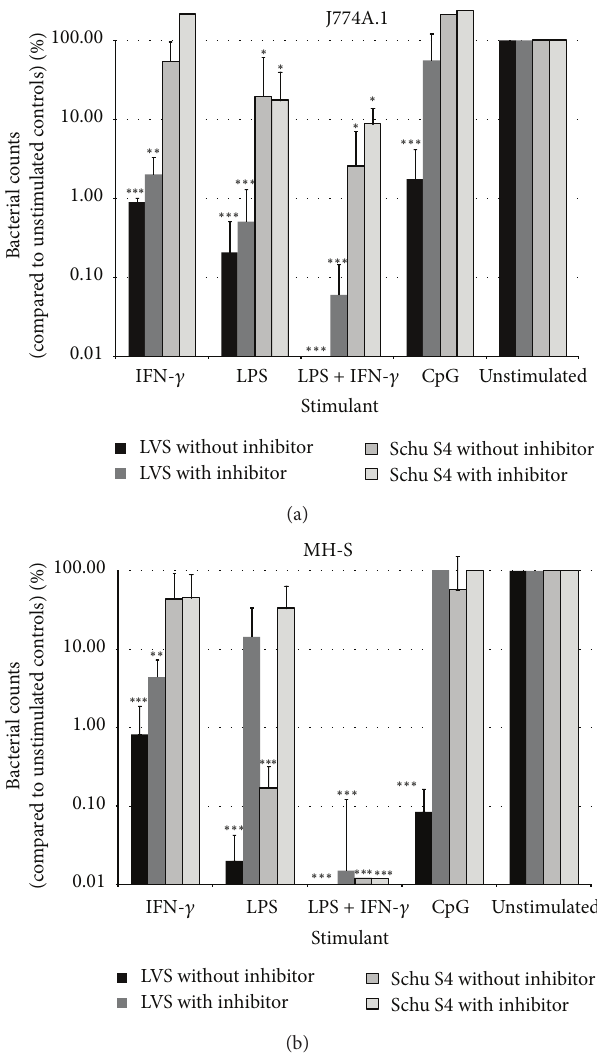
Figure 3: ((a) and (b)) Intracellular counts 24 hours after stimula- tion and infection of J774A.1 cells (a) and MH-S cells (b). Stimulant concentrations added were IFN- 𝛾 (1 𝜇 g/mL), LPS (5 𝜇 g/mL), IFN- 𝛾 + LPS (1 𝜇 g/mL + 5 𝜇 g/mL), and CpG (10 𝜇 g/mL). Nitric oxide pro- duction was inhibited by 4 mM N G -monomethyl-L-arginine added before stimulation. Values are the means and SEM from at least three independent experiments, with the starting infection given a value of 1% and the maximal growth achieved (in unstimulated cells) as 100%. Significant differences in intracellular counts between stimulatedandunstimulatedcellsareshown(significance ∗ 𝑃 < 0.05 , ∗∗ 𝑃 < 0.01 , and ∗∗∗ 𝑃 < 0.001 by Student’s 𝑡